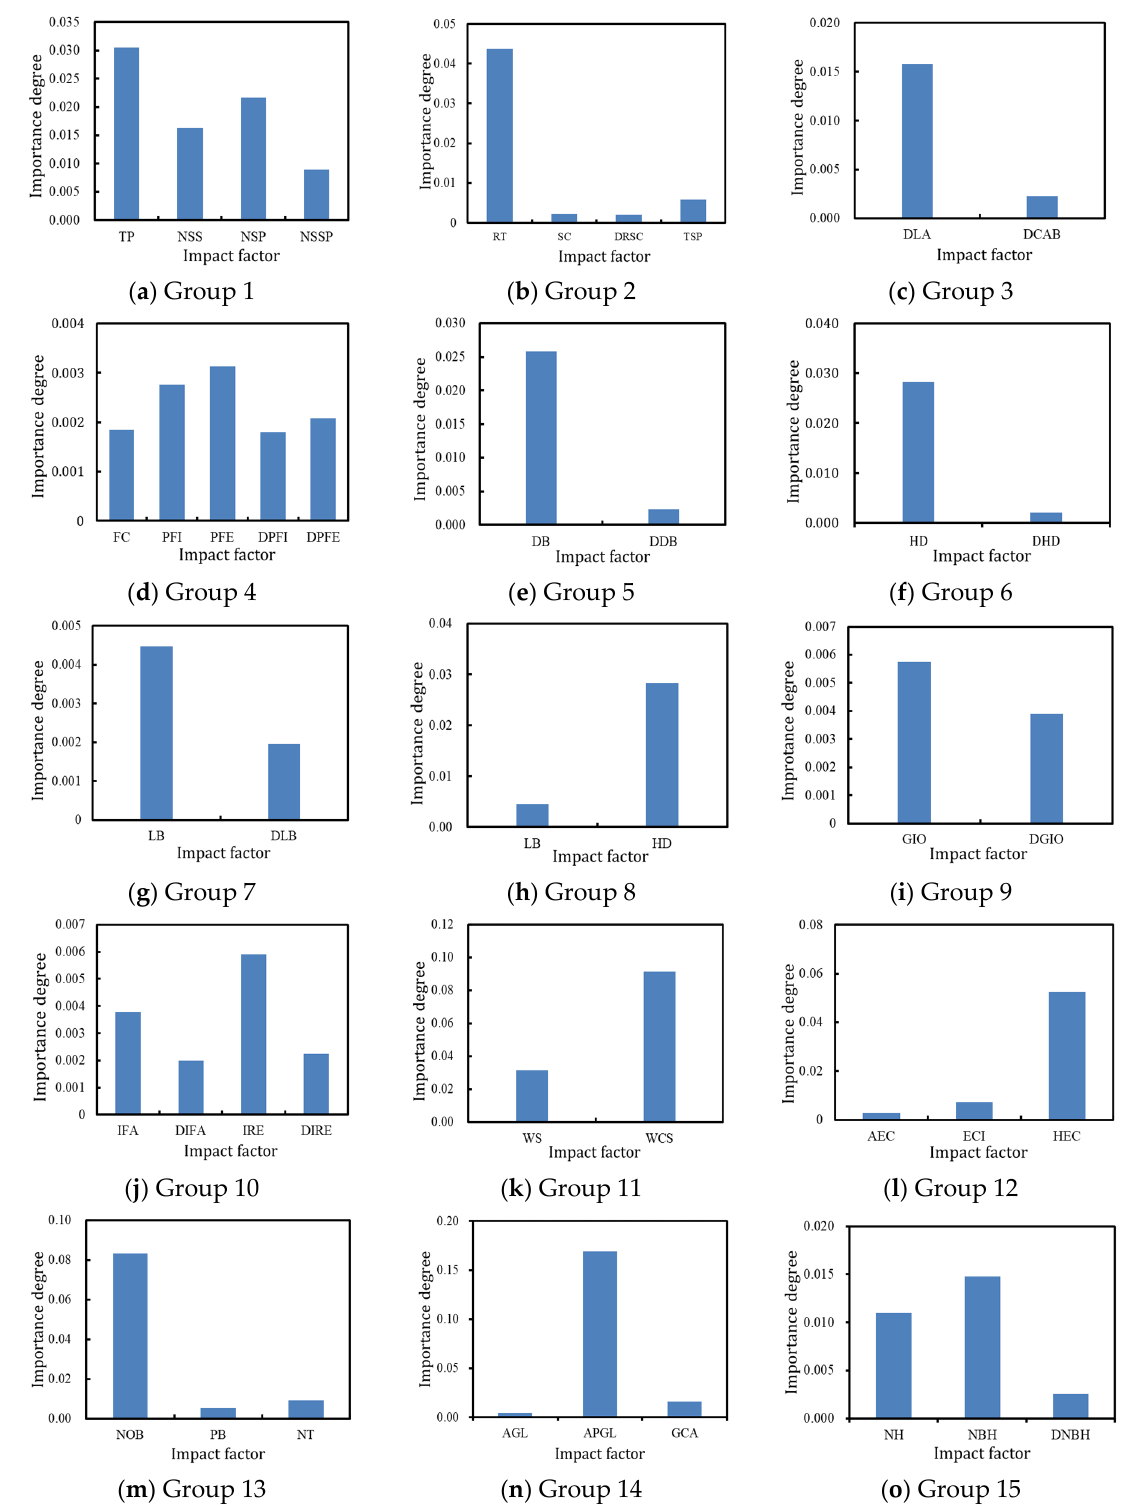
Figure 3. The importance degrees of significantly correlated variables in each group.